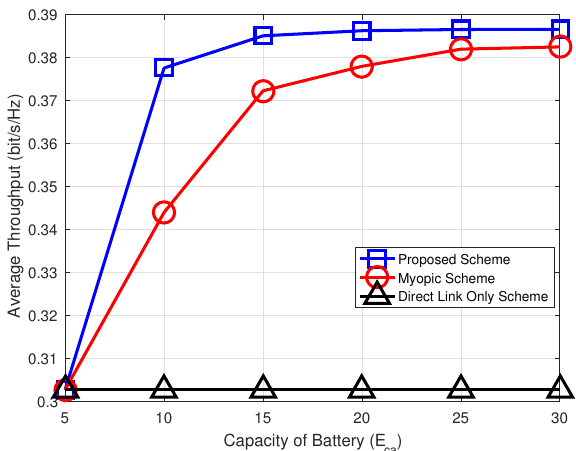
Figure 6. Average throughput versus capacity of battery.